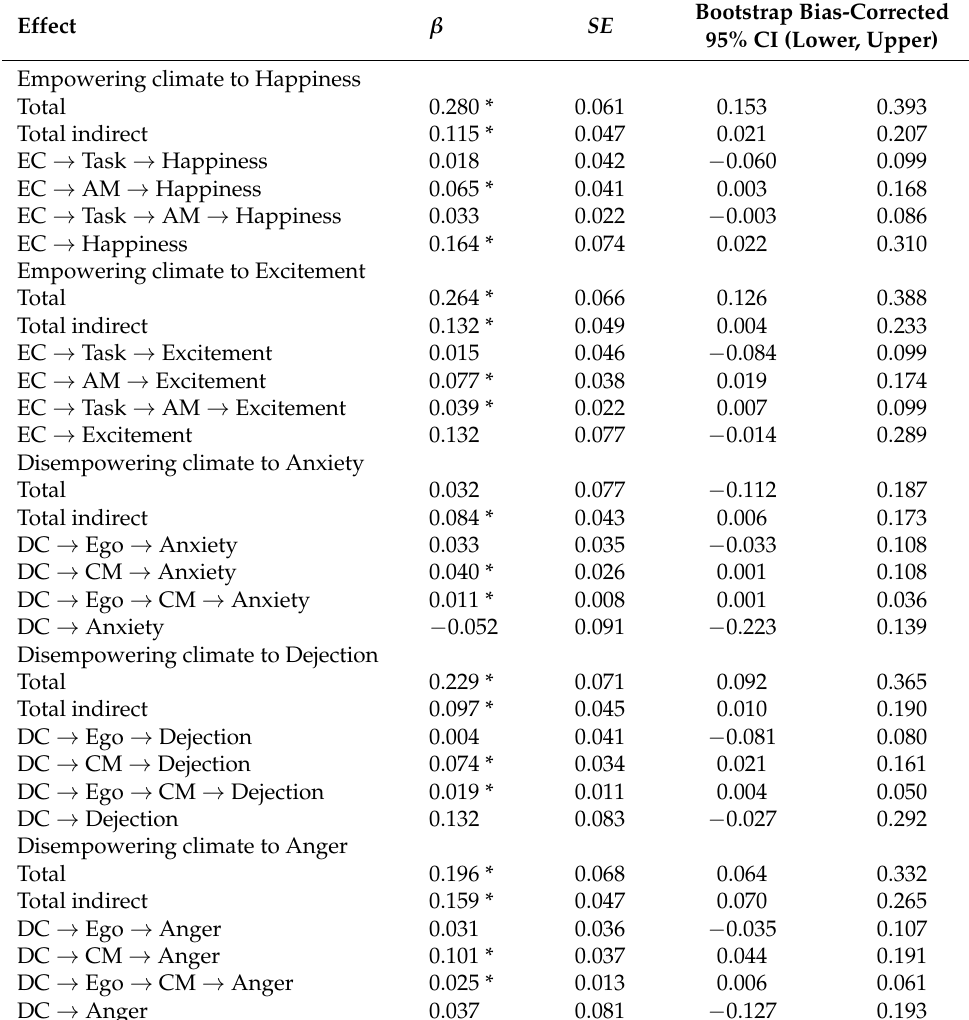
Table 3. Total, direct, and indirect effects for paths from empowering and disempowering climates to emotions via task- or ego-goal orientations, and autonomous or controlled